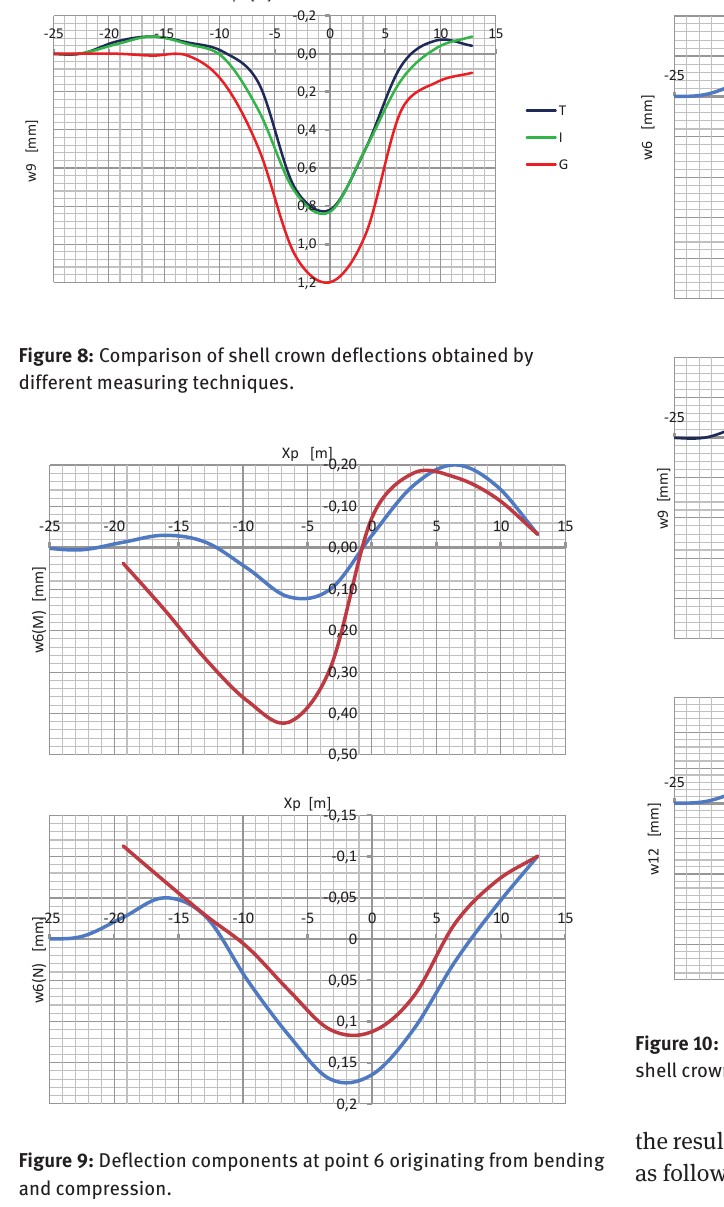
Figure 9: Deflection components at point 6 originating from bending and compression.